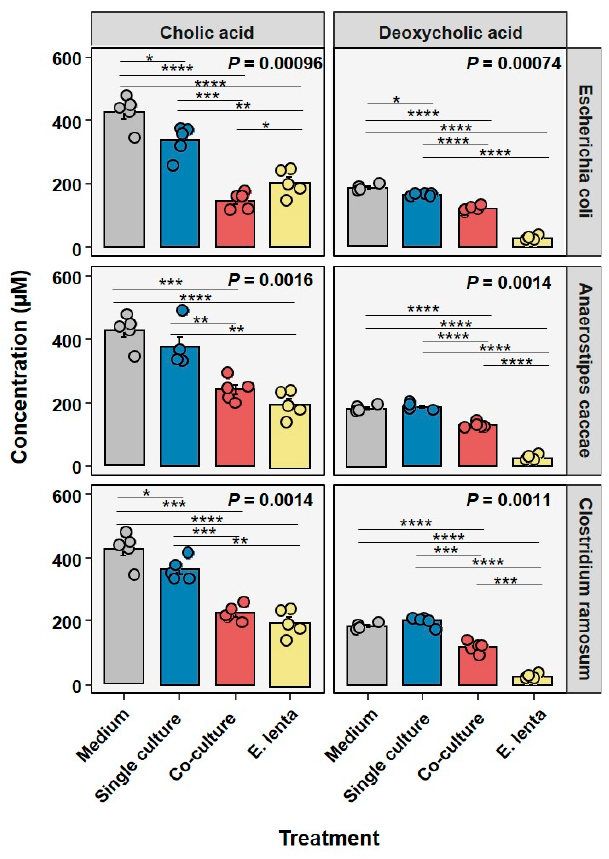
Figure 2. Determination of bile acid concentrations in single and co-culture after 6 h of incubation. For every sample, five replicates were measured and the bars represent the mean value. Group statistics were calculated by ANOVA with post-hoc pairwise Students t -test. (* p < 0.05, ** p < 0.01,*** p < 0.001 and **** p < 0.0001).